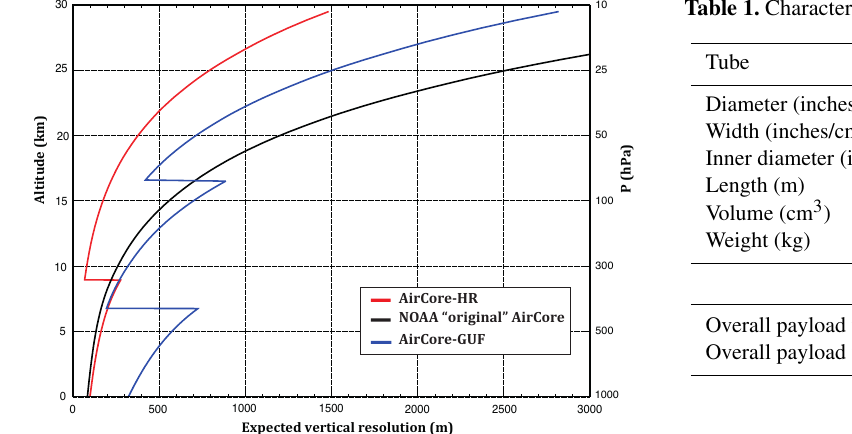
Figure 2. Comparison of the vertical resolution that can be expected with different AirCores for CO 2 measurements after 3h storage time before analysis: AirCore-HR (red), the original NOAA Air- Core (black) and AirCore-GUF (blue).